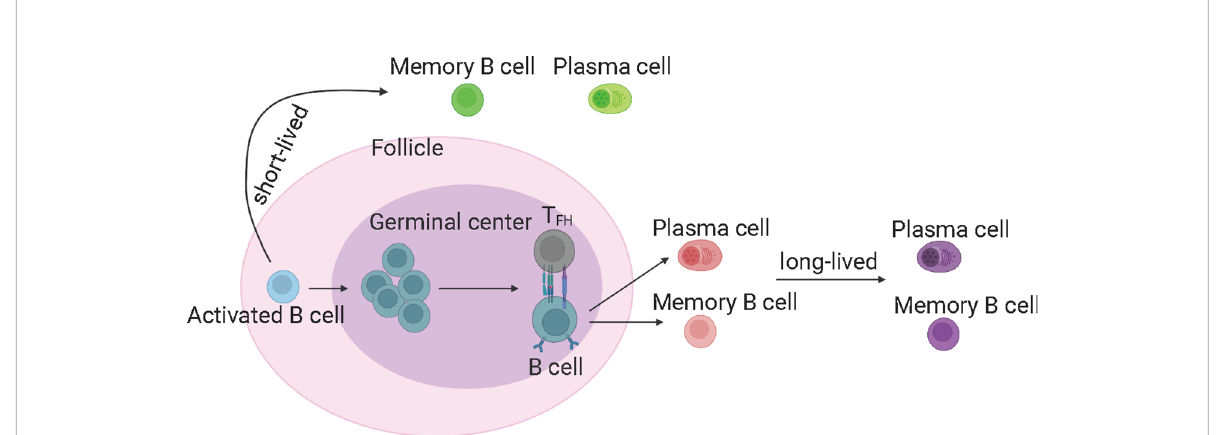
FIGURE 3 The germinal center reaction and the production of long-lived memory B cells and antibodies. The germinal center derived memory B cells and plasma cells are more stable and long-lived, and able to produce high-af fi nity antibodies. T FH , T follicular helper cells. The fi gure was created using